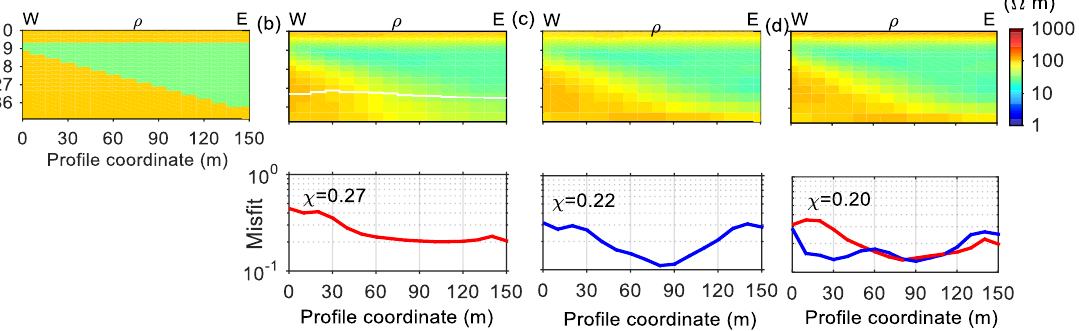
Figure 13. Comparison between the true resistivity value ( a ) and resistivity inversion results of the IP responses of the subtle chargeable medium: by x -data only ( b ); z -data only ( c ); and x and z data. ( d ) The meanings of the curves and the area are the same as in Figure 7.